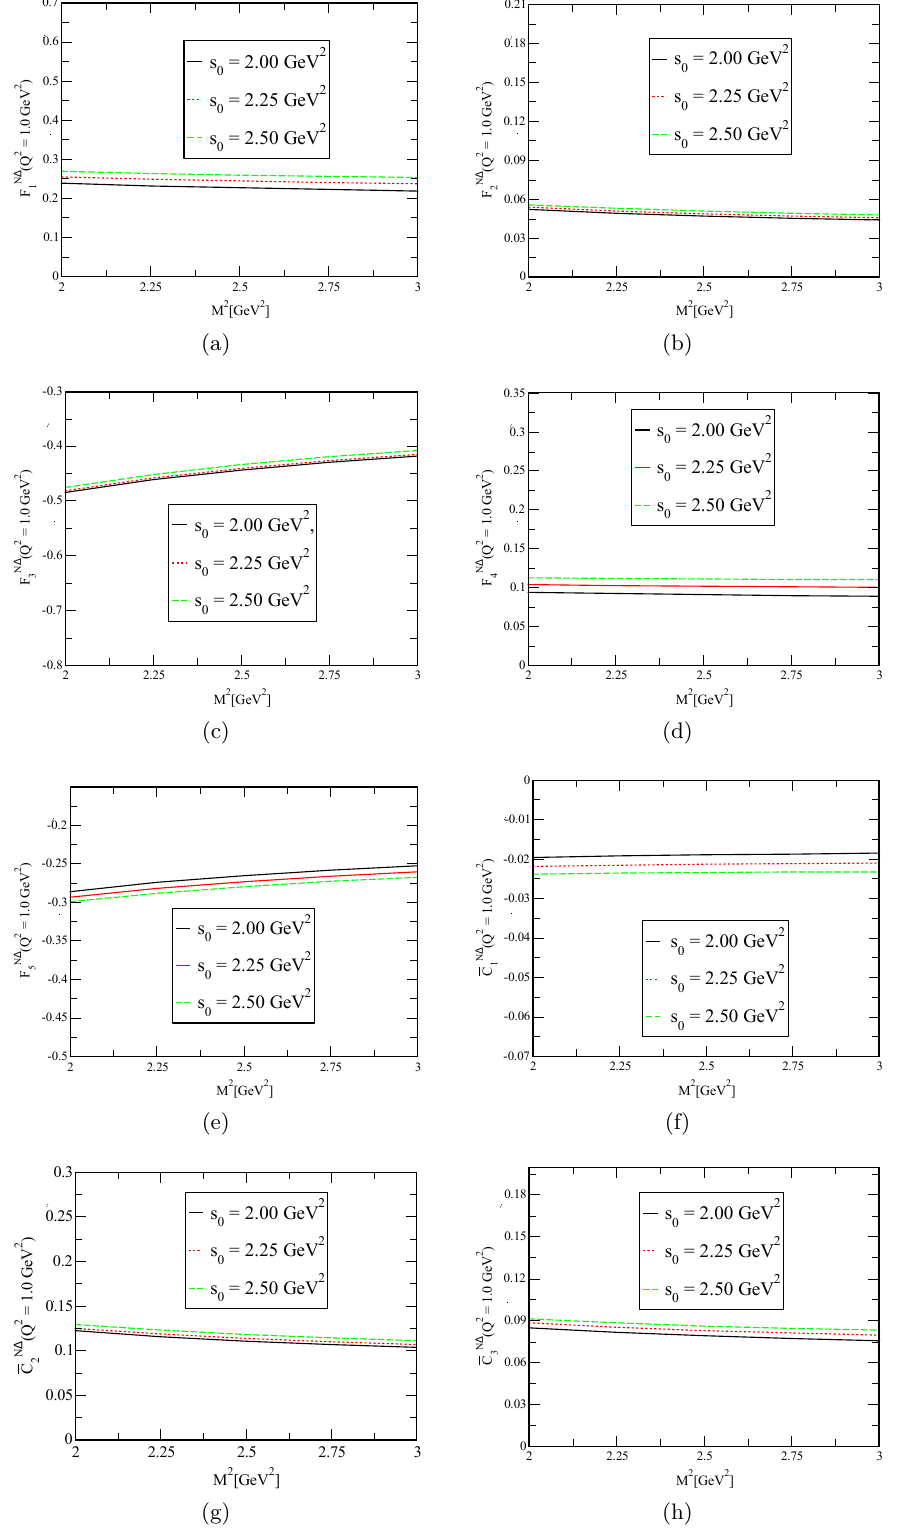
Figure 1 . The dependence of the N → ∆ transition GFFs on M 2 at Q 2 = 1 . 0 GeV 2 and three fixed values of the s 0 and set-I